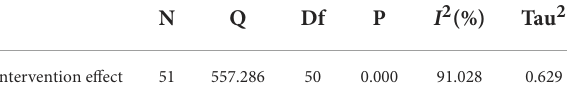
TABLE 2 Results of the homogeneity